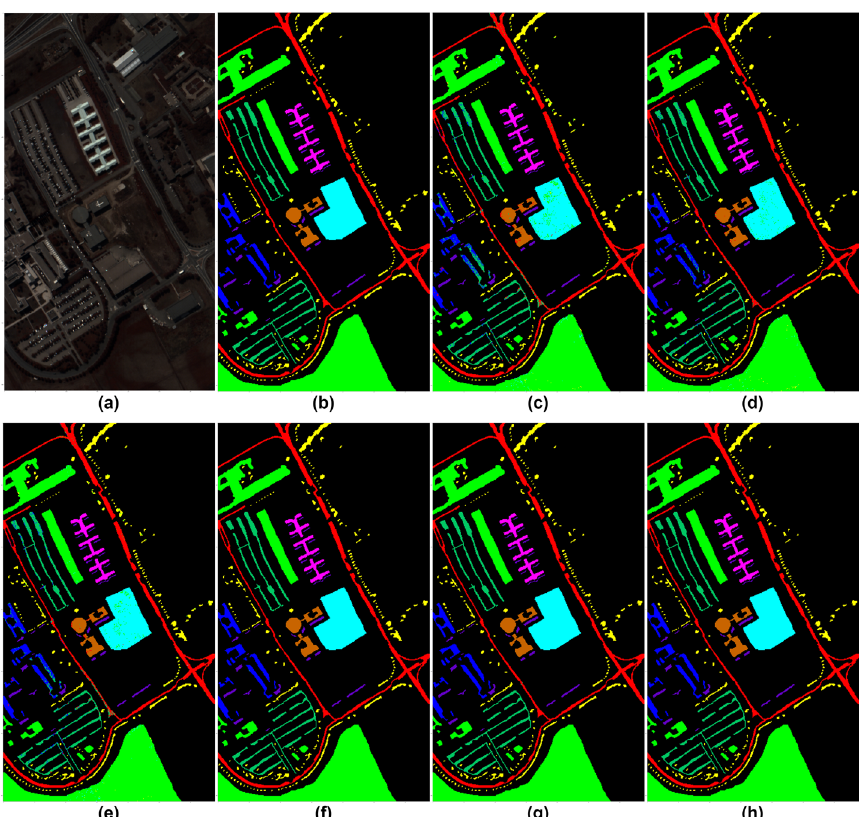
Fig. 7 The classification map for the Pavia University dataset. a RBG Image b Ground Truth c – e Predicted classification maps for HybridSN, single U-Net, and CEU-Net with no patching respectively. f – h Predicted classification maps for HybridSN, single U-Net, and CEU-Net with patching with a patch size of 10x10